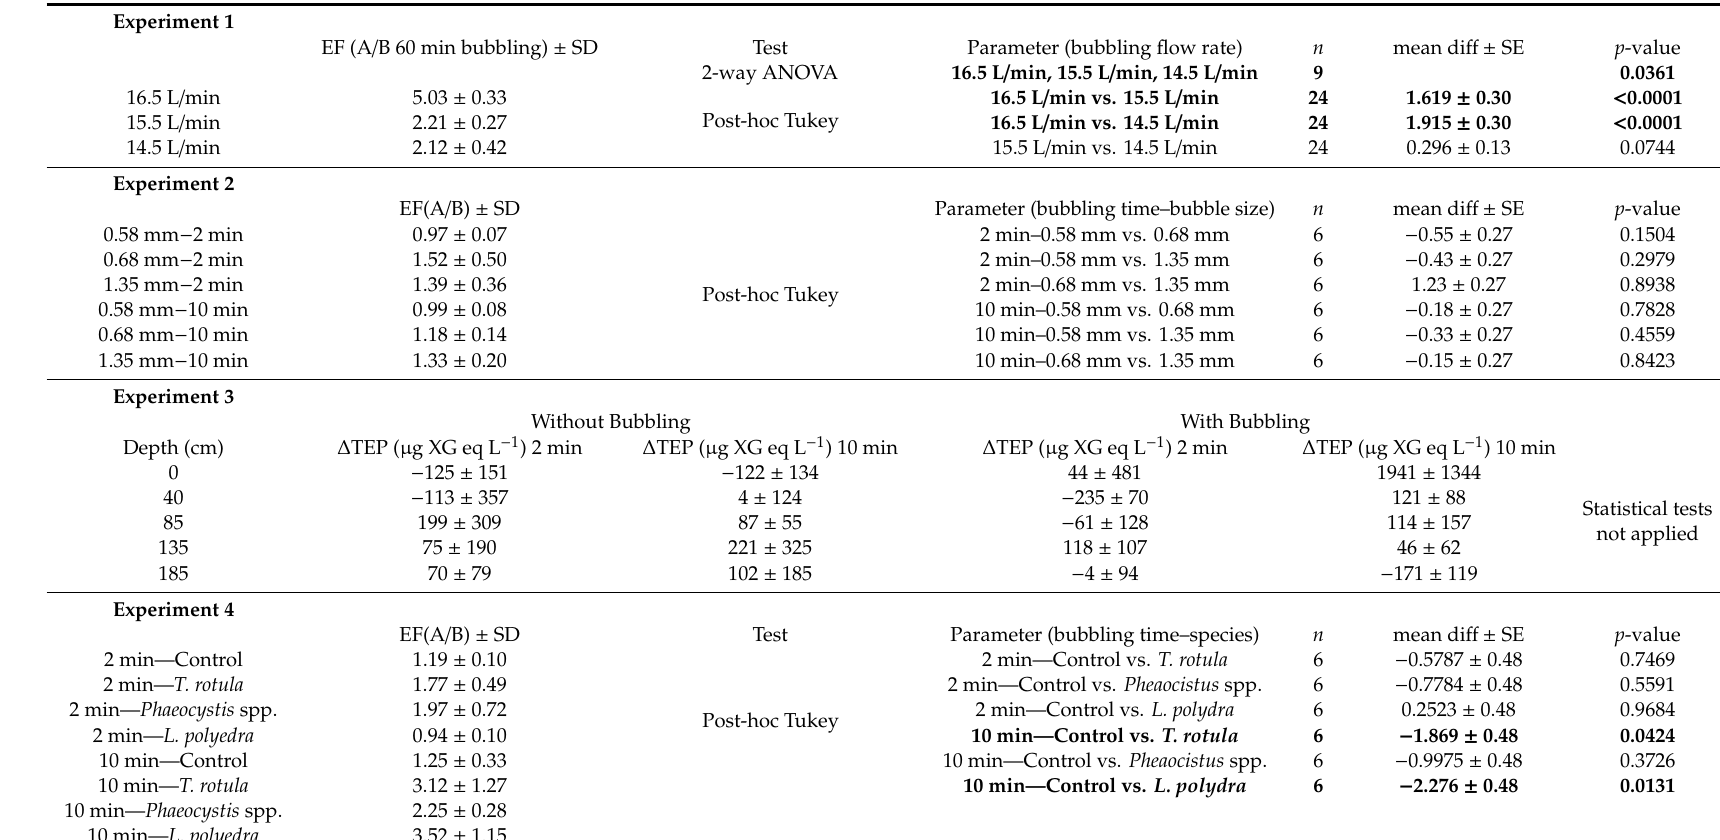
Table 1. Summary table showing enrichment factor (EF) from after bubbling / before bubbling (A / B) ± standard deviation (SD) for TEP from all experiments, as well as statistical analysis of enrichment of TEP during experiments. Significant results are in bold. Experiment 3 shows changes in TEP concentrations after 2 and 10 min ( ∆ TEP), results were analyzed as depth profiles, and thus no statistics were